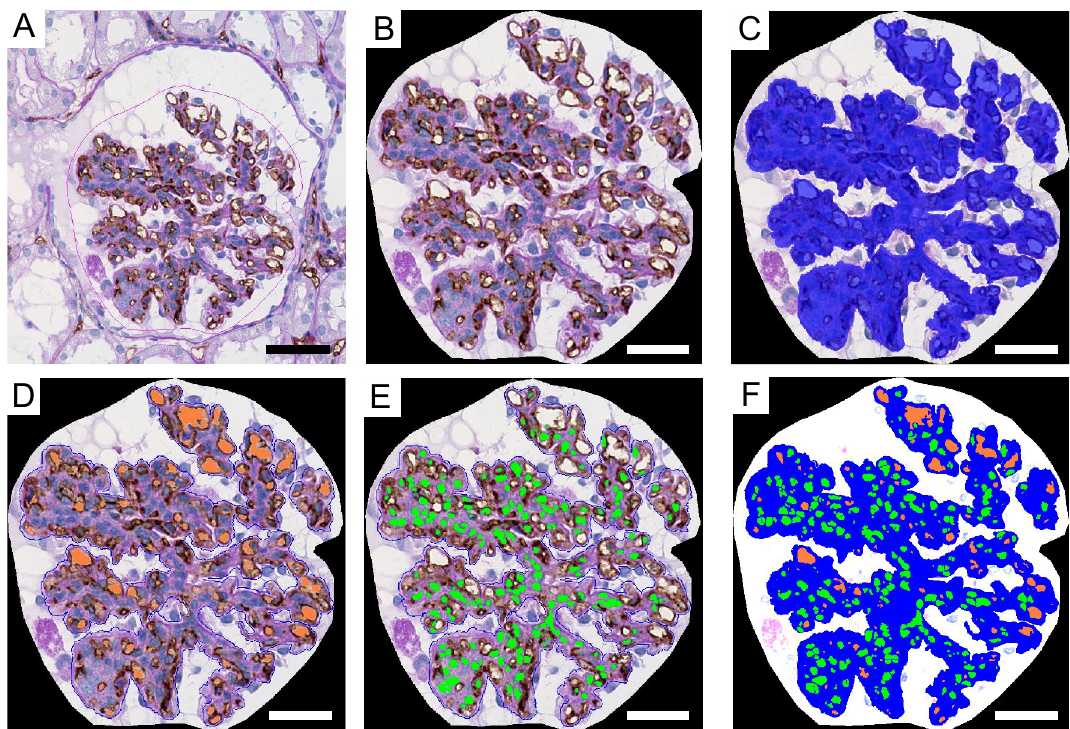
Figure 3. Morphometric analysis process using a computer-assisted image analyzer. Morphometric analysis performed on a PSAGN biopsy sample that has been immunostained for CD34 with PAS counterstain. The glomerulus is outlined in pink ( A ). The outline of the glomerular tuft was extracted ( B ) and the glomerular tuft area was colored blue ( C ). The capillary lumen area was colored orange ( D ). The nuclei were colored green ( E ). These images were combined ( F ). Scale bars, 50 μm ( A ); 30 μm ( B – F